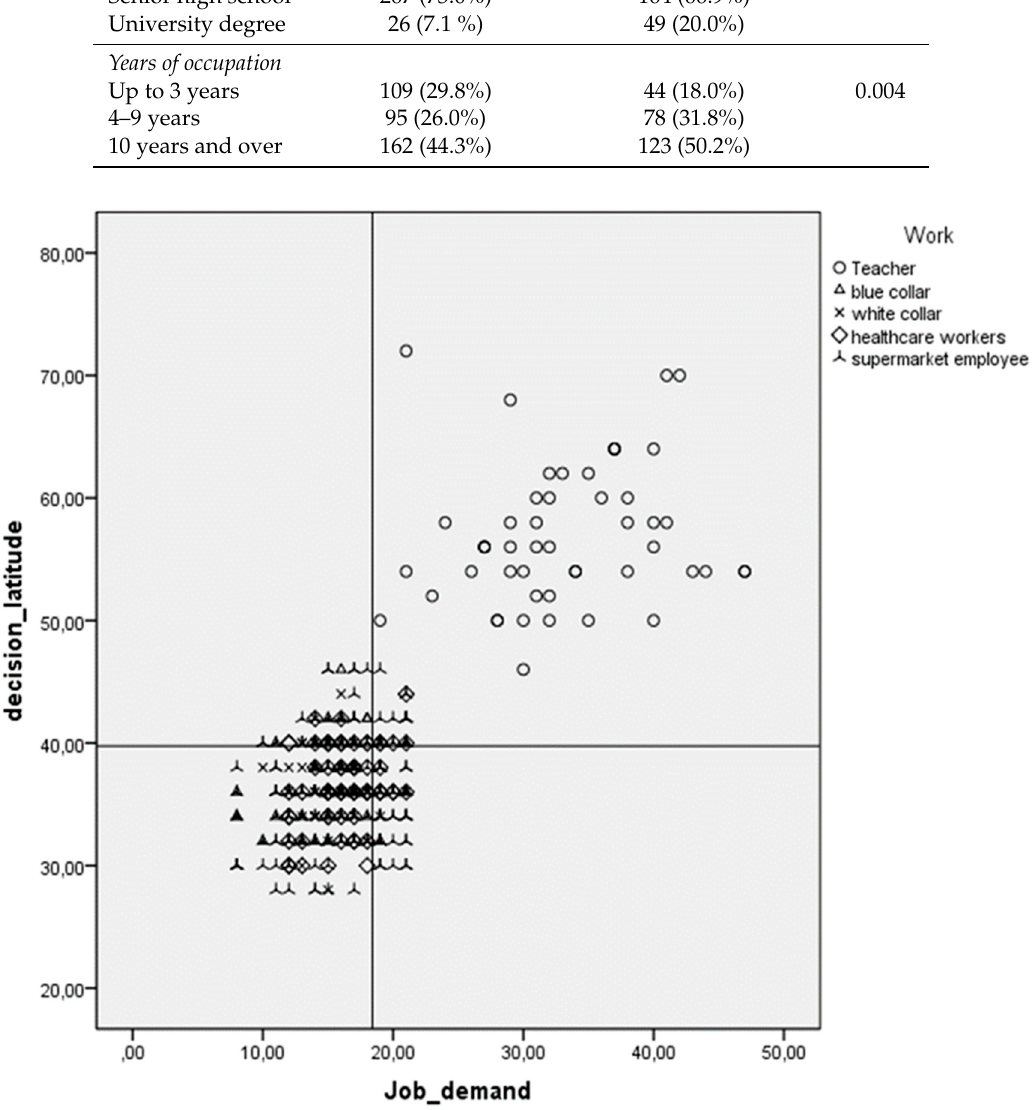
Figure 1. Study population split in four quadrants according to Karasek.